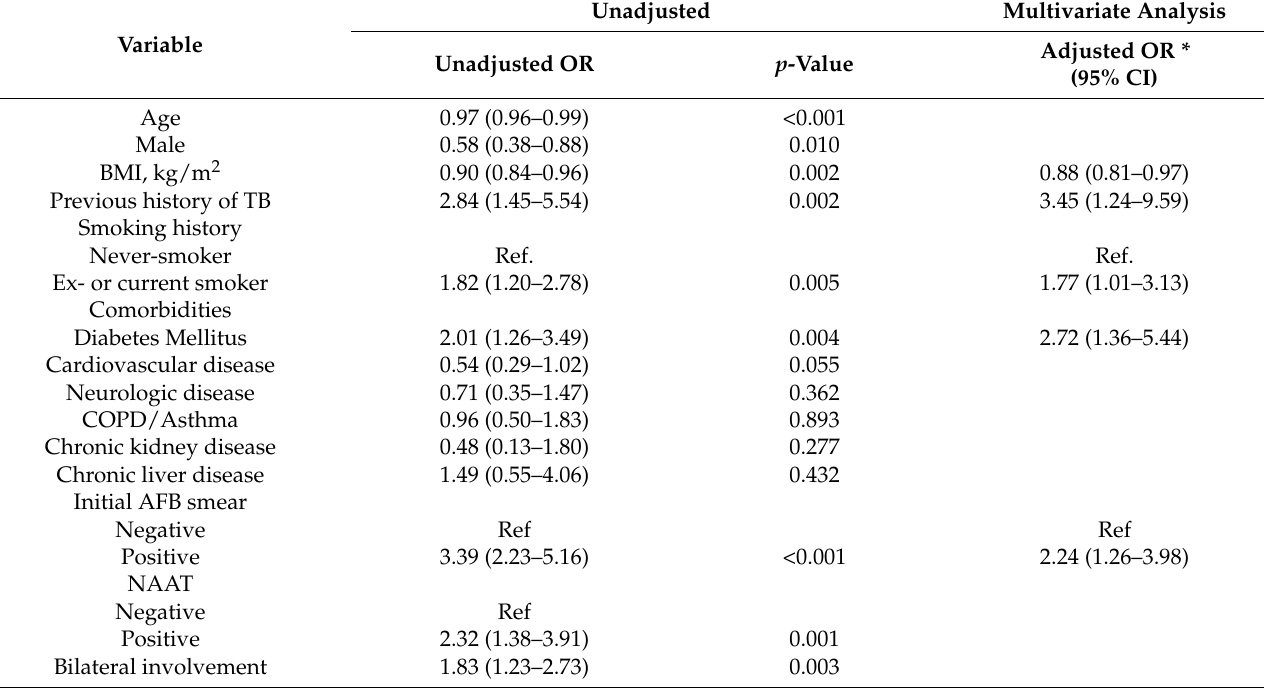
Table 2. Factors associated with cavitary